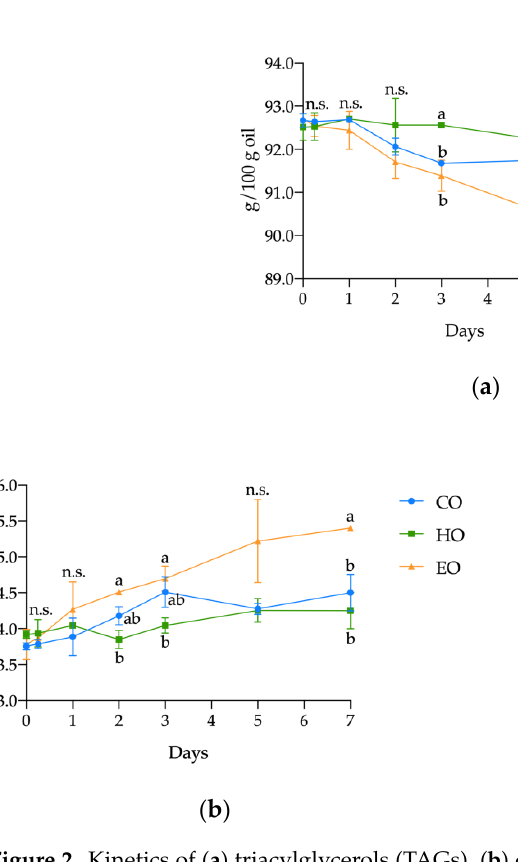
Figure 2. Kinetics of ( a ) triacylglycerols (TAGs), ( b ) diacylglycerols (DAGs), and ( c ) free fatty acids (FFAs) in stripped linseed oil without antioxidants (CO), with hemp extract (HO), and with α -tocopherol (EO) during storage. Values (g / 100 g oil) are expressed as mean ± standard deviation ( n = 3). Results of ANOVA with Duncan’s test are reported between CO, HO, and EO within the same day. Di ff erent letters a, b are significantly di ff erent at p < 0.05. n.s. = not significant (cid:80) Table 1. Kinetics of total (g / 100 g oil) saturated fatty acids ( SFAs), monounsaturated fatty acids (cid:80) (cid:80) ( MUFAs), and polyunsaturated fatty acids ( PUFAs) in CO, HO, and EO during 7 days of treatment.